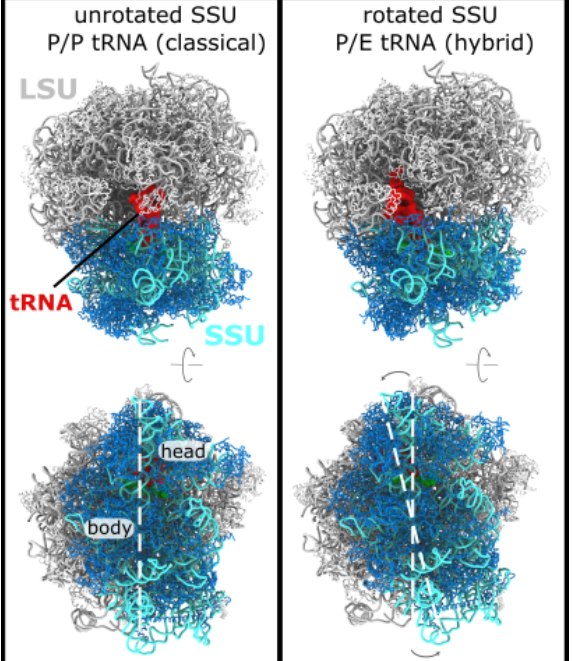
Figure 1. Subunit rotation in a eukaryotic ribosome. The elongation cycle of the ribosome involves numerous large-scale conformational rearrangements. ( left ) In the ribosome, the nascent protein chain is attached to the P-site tRNA molecule (red). A “classical” P/P configuration is shown. In this state, the small subunit (SSU; rRNA:cyan, protein:blue) is described as being in an “unrotated” conformation. Perspective shown in the bottom panel is rotated ∼ 90 ◦ about the horizontal axis. ( right ) After peptide bond formation, where the nascent chain is transferred to an incoming tRNA molecule, the P-site tRNA adopts a hybrid P/E conformation, where it is displaced toward the E site of the large subunit. P/E formation is also accompanied by a ∼ 8 ◦ counterclockwise rotation of the SSU, relative to the large subunit (LSU; rRNA:gray, proteins:white). White dashed lines are shown to highlight the relative rotation of the SSU. In the current study, we apply molecular dynamics simulations to probe the dynamics and energetics of SSU rotation in yeast. Structures shown are PDB entries 3J78 (unrotated, classical) and 3J77 (P/E, rotated)